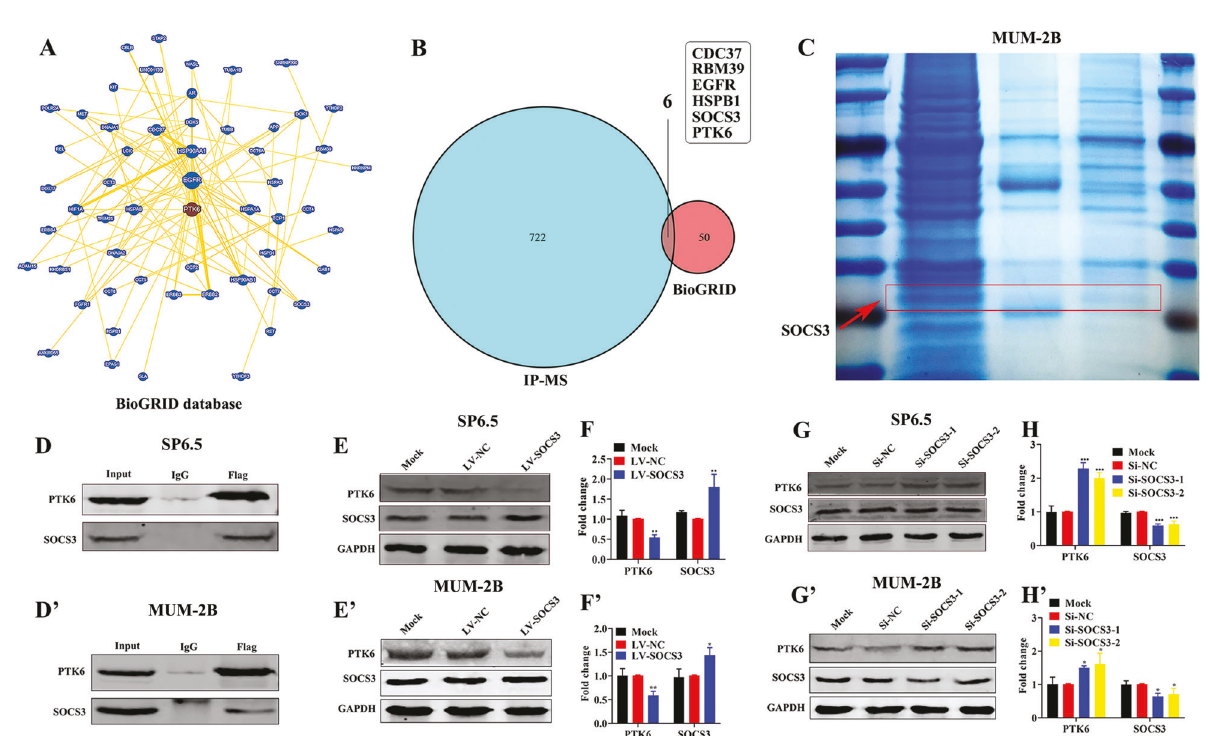
Fig. 5 SOCS3 binds to PTK6 and inhibits PTK6 expression. A Network diagram of proteins related to PTK6 from the BioGRID database. B The Venn diagram of IP-MS and BioGRID. C The results of the SDS-PAGE visualized by Coomassie Brilliant Blue staining after immunoprecipitating. D , D ’ Coimmunoprecipitation analysis of PTK6 and SOCS3 in UM cells. E , F and E ’ , F ’ Western blotting analysis of SOCS3 and PTK6 in UM cells overexpressing SOCS3. G , H and G ’ , H ’ Western blotting analysis of SOCS3 and PTK6 in UM cells with SOCS3 knockdown. The above data were analyzed using one-way ANOVA with Bonferroni. ( D – H : SP6.5 cell; D ’– H ’ : MUM-2B cell; data were presented as the mean ± SD; n = 3; * p < 0.05, ** p < 0.01, *** p <